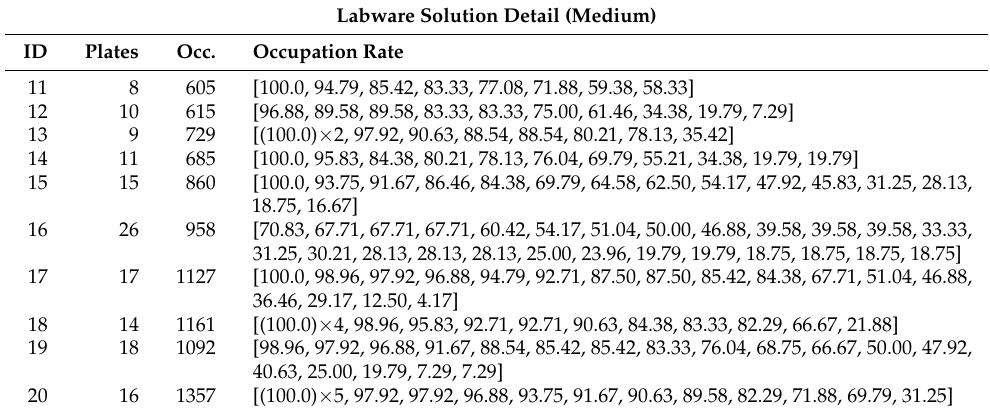
Table A3. Labware solutions detailed for medium files.